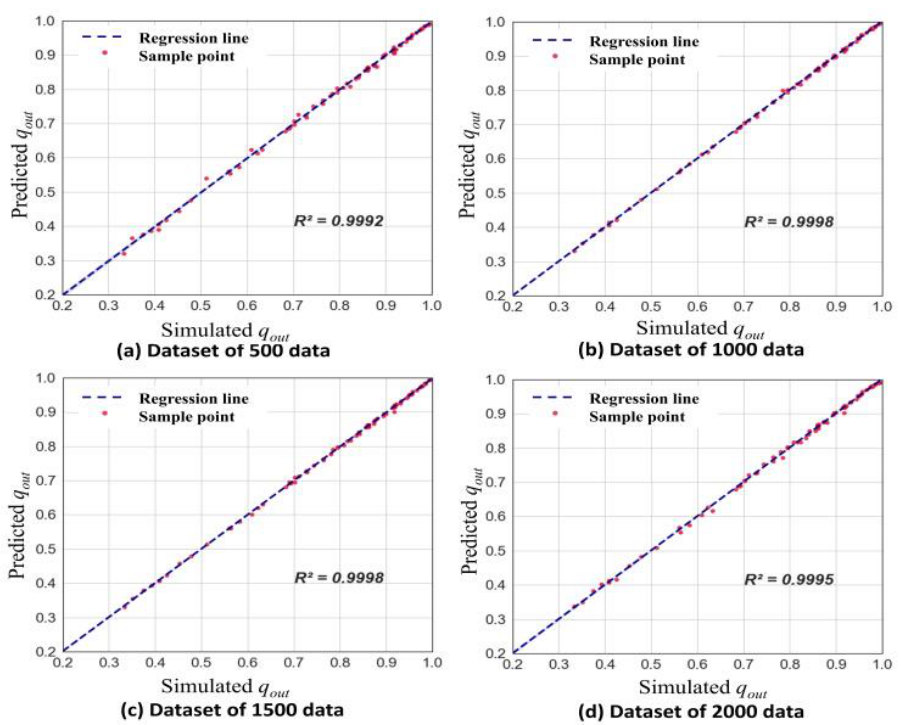
Figure 11. Coefficient of determination R 2 of 81 samples in test dataset with four sizes of datasets: